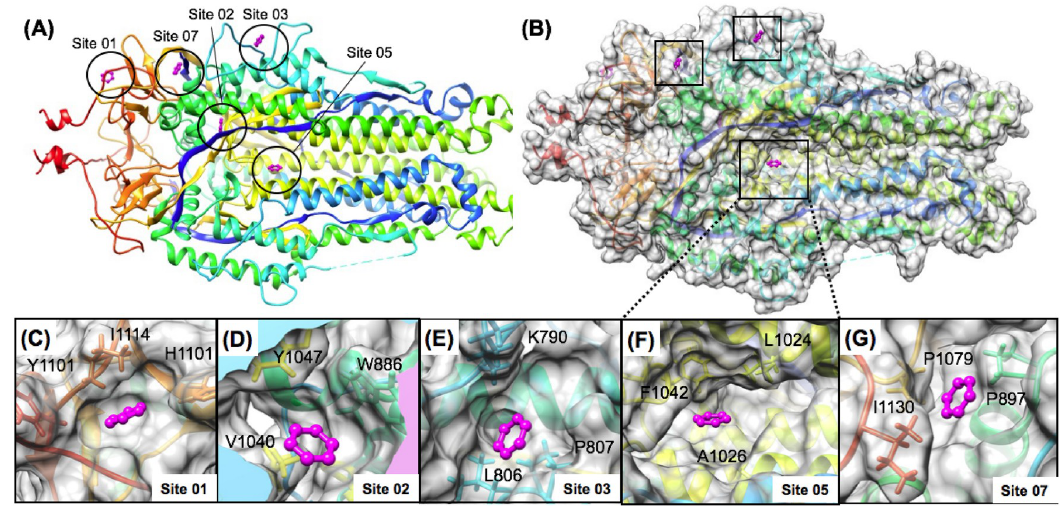
Fig 16. Favorable aromatic pharmacophore binding sites identified on the S2 spike protein. Favorable Sites 01, 02, 03, 05 and 07 are shown in magenta sites on a rainbow ribbon diagram in (A) and on a surface representation in (B). Important hydrophobic residues forming these sites are shown for Site 01 (C) Site 02 (D) Site 03 (E) Site 05 (F) and Site 07 (G).